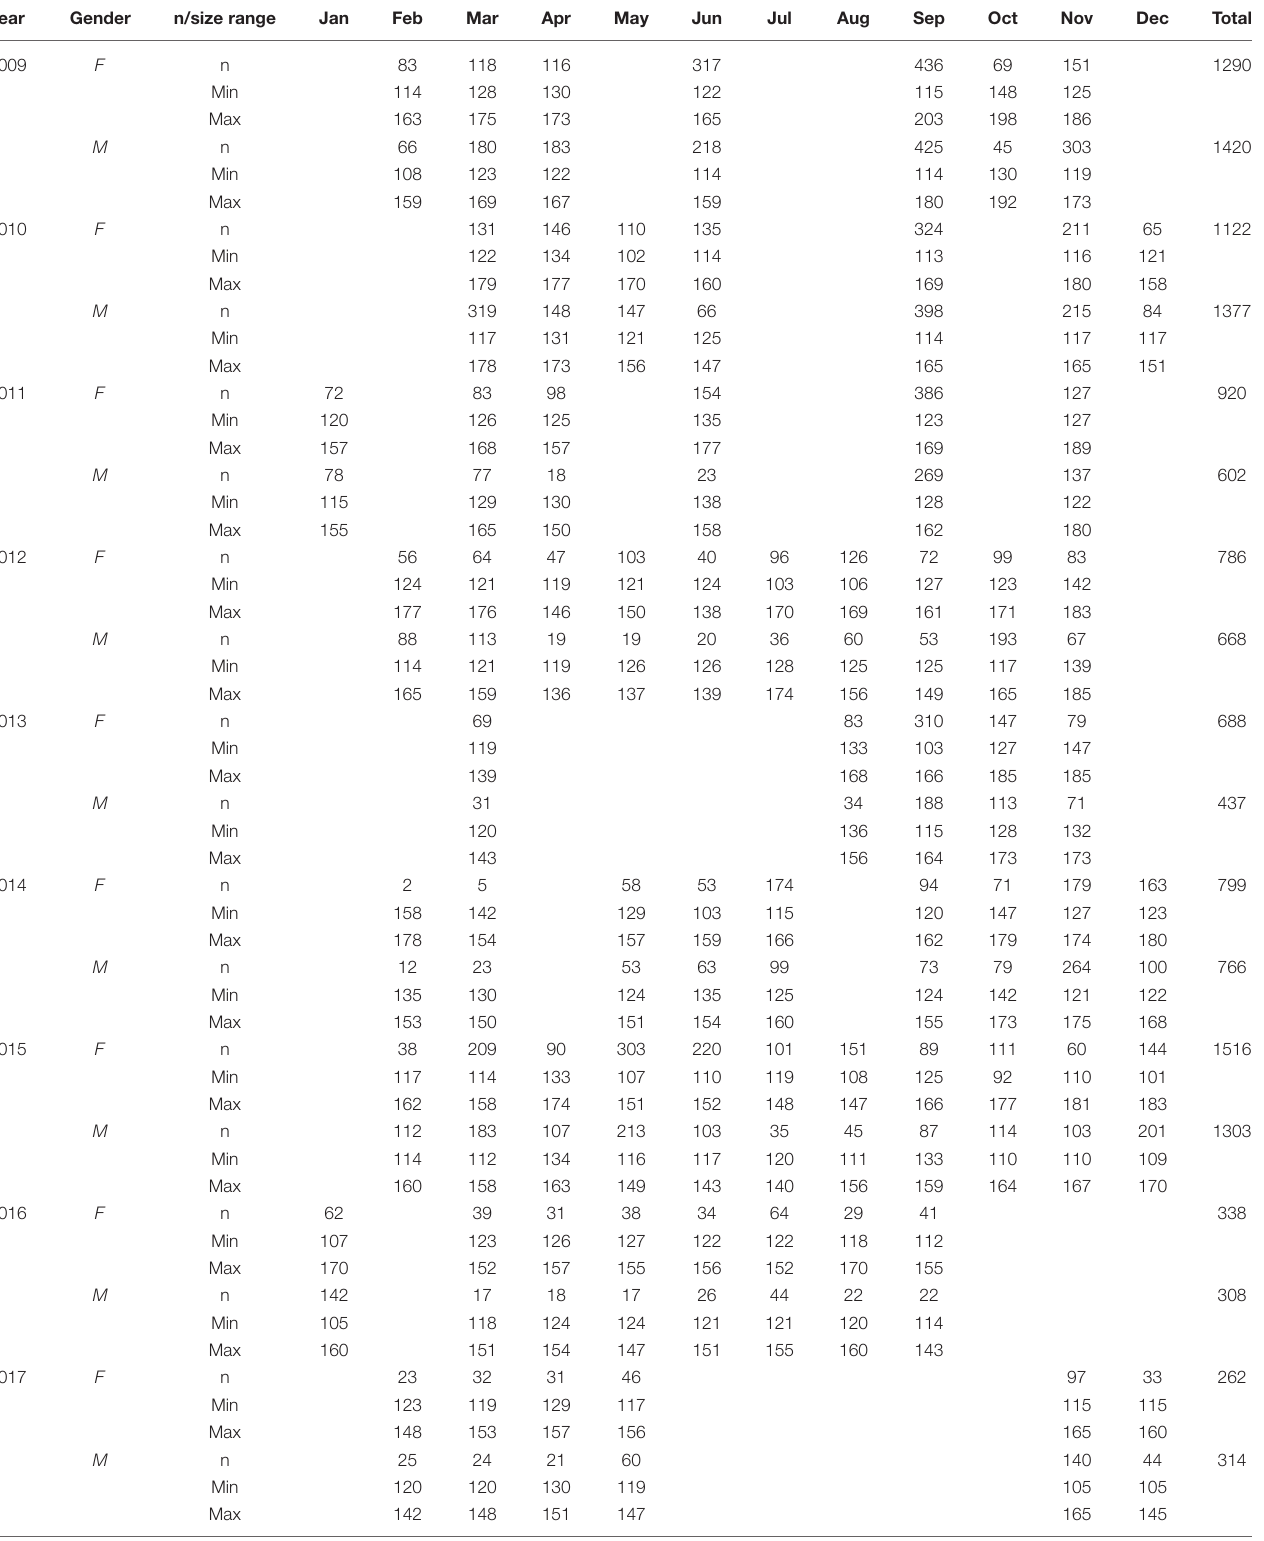
TABLE 1 | Number of European sardine sampled ( n ) for each gender (i.e., female [F] and male [M]) along the study period, by year and month. Year Gender n/size range